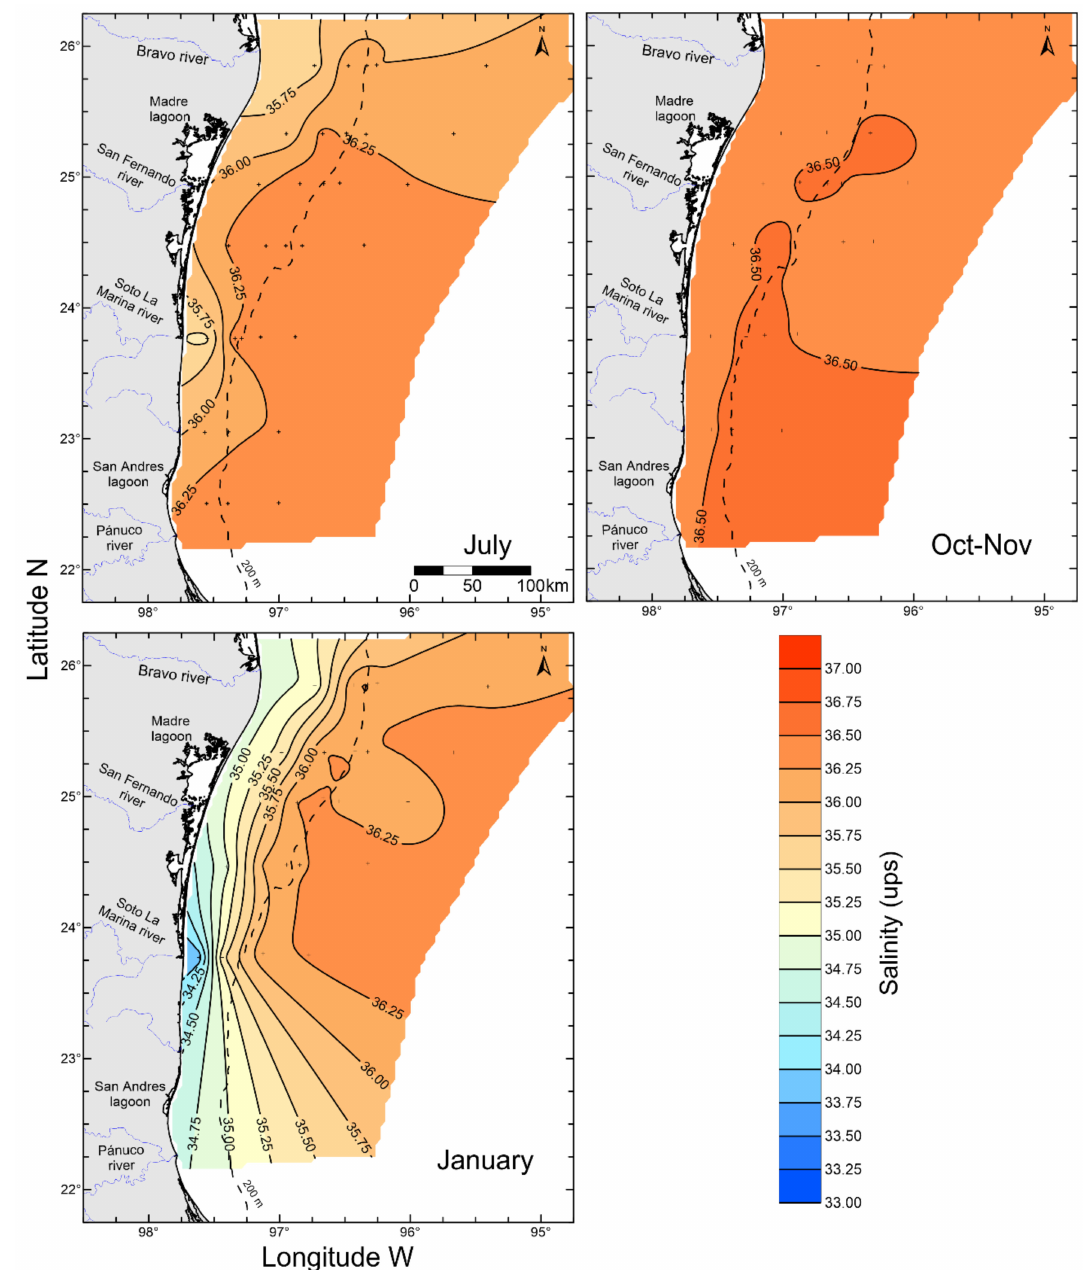
Figure 3. Mean integrated salinity (psu) in the upper 50 m layer in the western Gulf of Mexico. Chlorophyll concentration was low (<1.5 mg m − 3 ) in all the studied seasons. The highest values were registered on the inner shelf in July and January (Figure 4). In addition, mean zooplankton biomass in the neritic zone was higher in July (9.7 ± 4.5 g 100 m − 3 ) and January (8.3 ± 4.9 g 100 m − 3 ) than in October–November (4.5 ± 3.5 g 100 m − 3 ). The highest biomass values were found at the stations close to the coast in July and January. In October–November, values were low both in the neritic zone and in the oceanic zone, with a maximum value close to the mouth of the Soto la Marina River (Figure